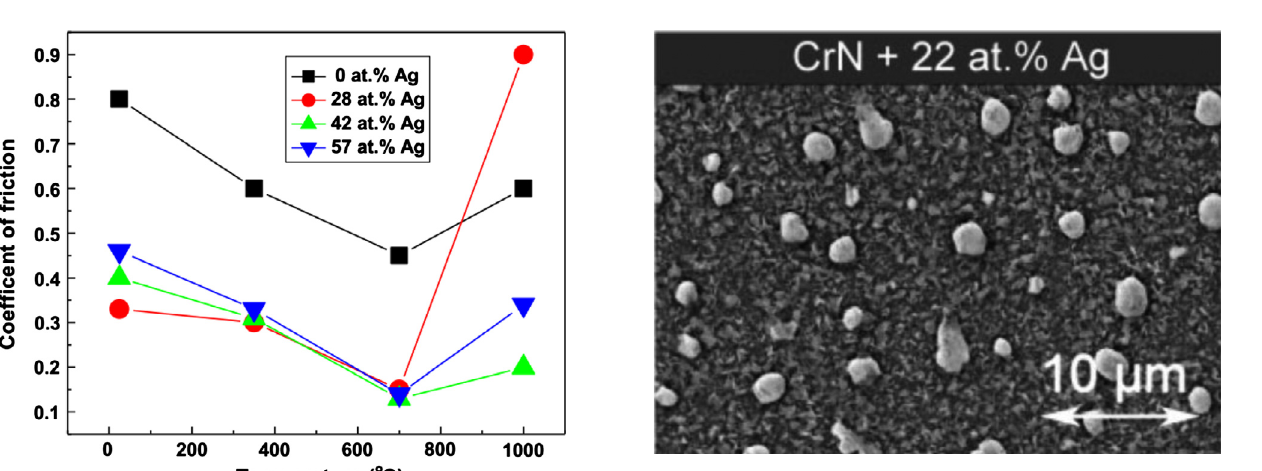
Figure 5. SEM micrographs of the surface of CrN-Ag coating indicating formation of Ag agglomerate of the coatings surface after annealing at 600 (cid:2) C for 90 min